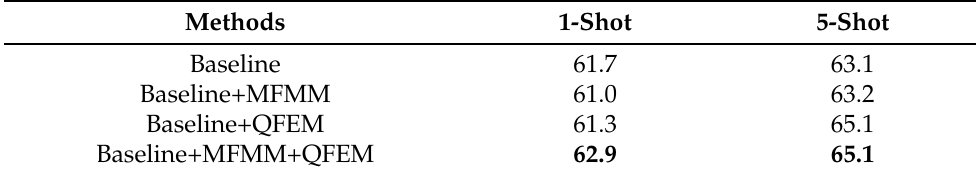
Table 3. MFMM and QFRM. The backbone is ResNet-50 MFMM: Multi-Scale Feature Matching Module. QFRM: Query Feature Enhancement